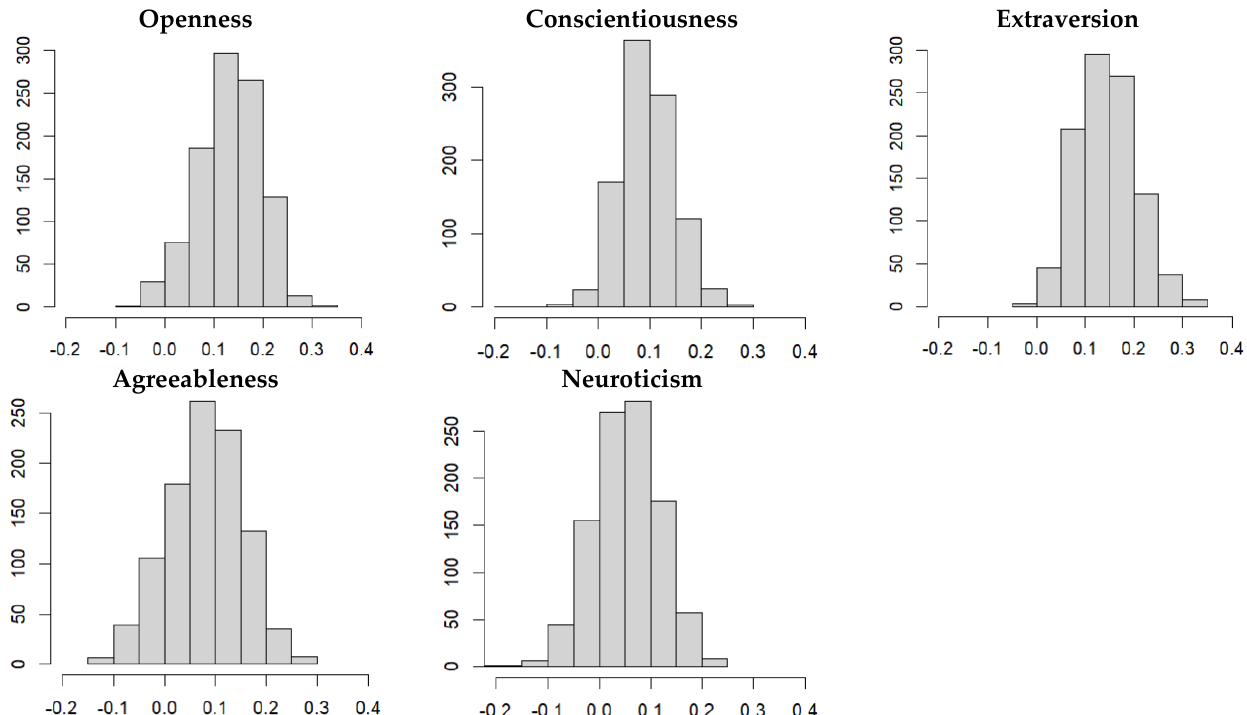
Figure 4. Distribution of model performances ( R measures) in the validation data sets. x-axis ranges from − 0.20 to 0.40.